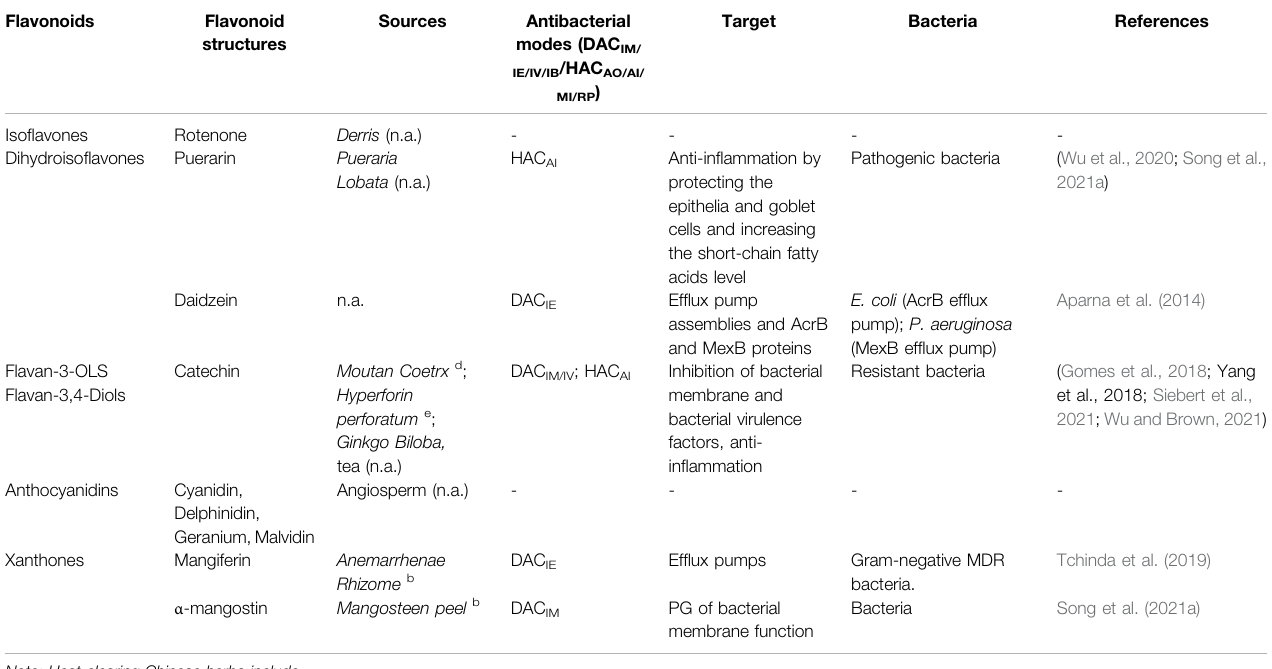
TABLE 1 | ( Continued ) Antibacterial modes of natural plant fl avonoids and the main target